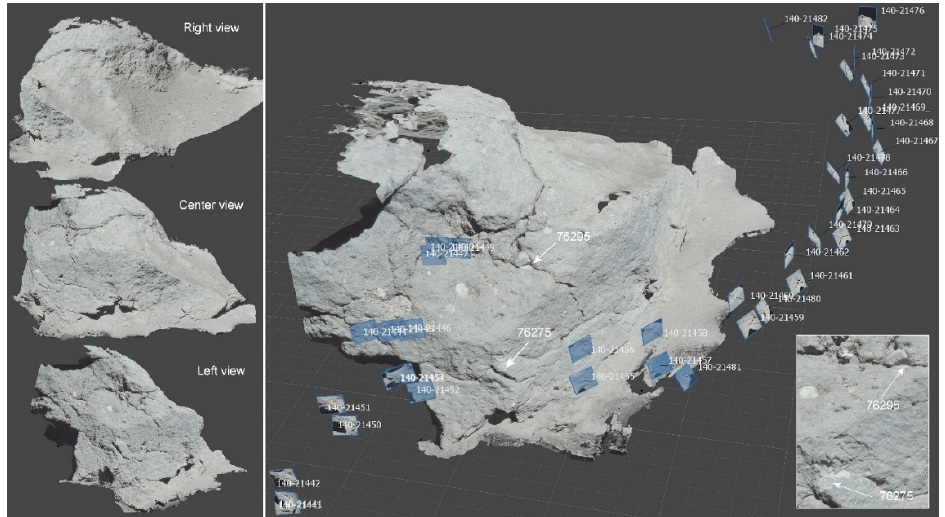
Figure 5. Photogrammetric reconstruction (textured 3-D model) of the northern most boulder fragment at Station 6, informally named Boulder 1 by previous authors. The position and orientation of the 42 entry Apollo images AS17-140-21441 to As-140-21482 computed from Metashape, are indicated in the perspective view on the right.